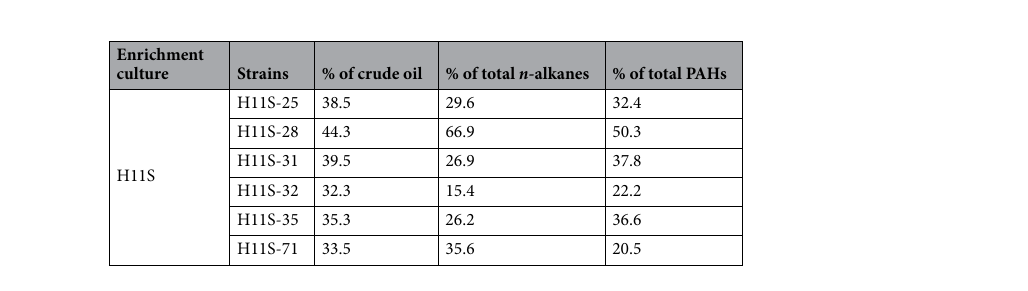
Table 3. Degradation efficiencies of crude oil, total n -alkane and PAHs by 6 isolated strains from the enrichment culture H11S.